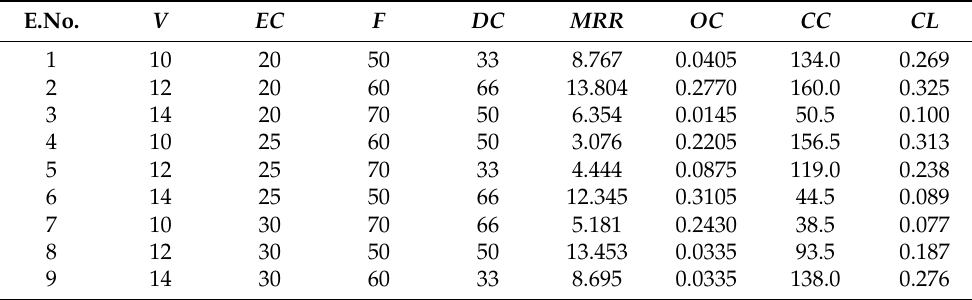
Table 2. Details of experiments (E)—parameters and responses—annealed.